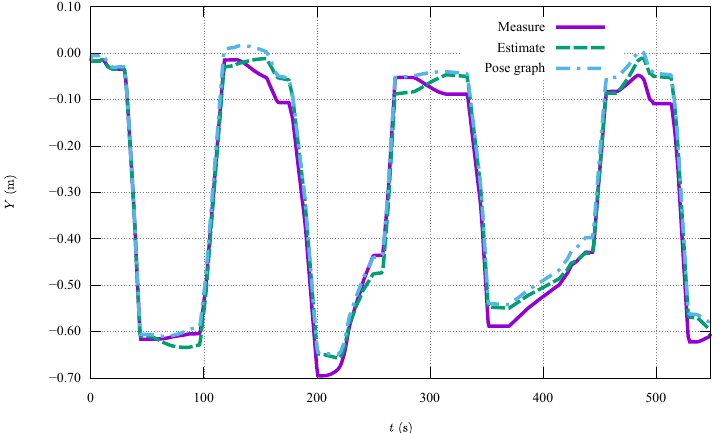
Figure 13. Y -direction position of the robot. The robot’s positions in the horizontal direction during translational movement are adjusted by the loop closure.